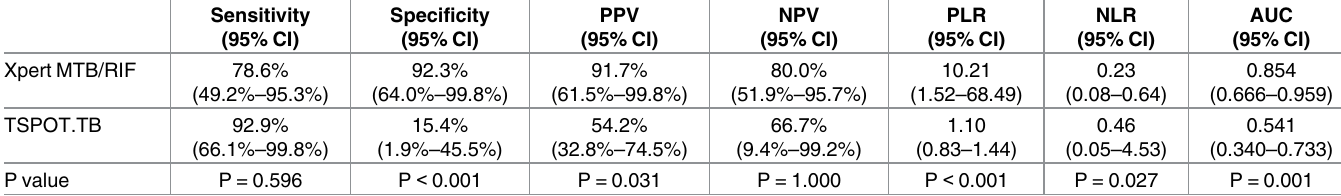
Table 2. Diagnostic efficiency of Xpert MTB/RIF and TSPOT.TB tests, using that of histopathology as a referencestandard. P-values corresponded to statistical comparisons betweenXpert MTB/RIF and TSPOT. TB